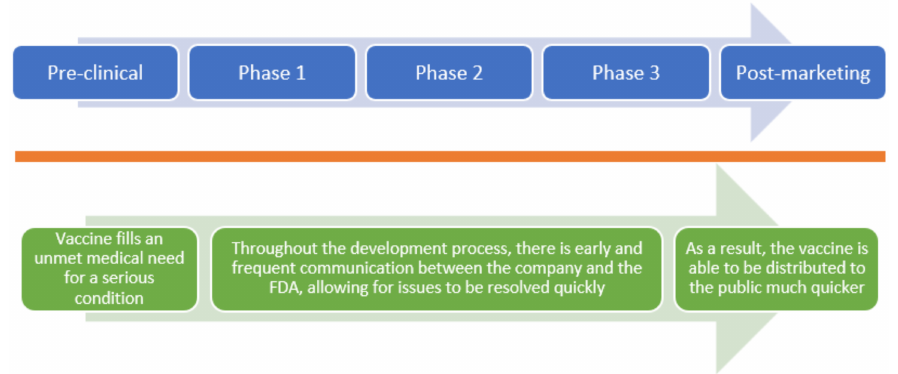
Figure 3. FDA’s Fast-Track approval process. The figure above shows the standard approval process in blue, while the Fast-Track approval process is shown in green. After the drug company requests Fast Track, the FDA will evaluate the drug and make a decision within 60 days. With a Fast Track designation, the sponsors can also request a Rolling Review, so the manufacturer can submit the finished BLA or NDA to the FDA for review instead of waiting for the entire application to be completed. Additionally, therapeutic candidates that have been permitted a Fast Track designation are also eligible for Accelerated Approval and Priority